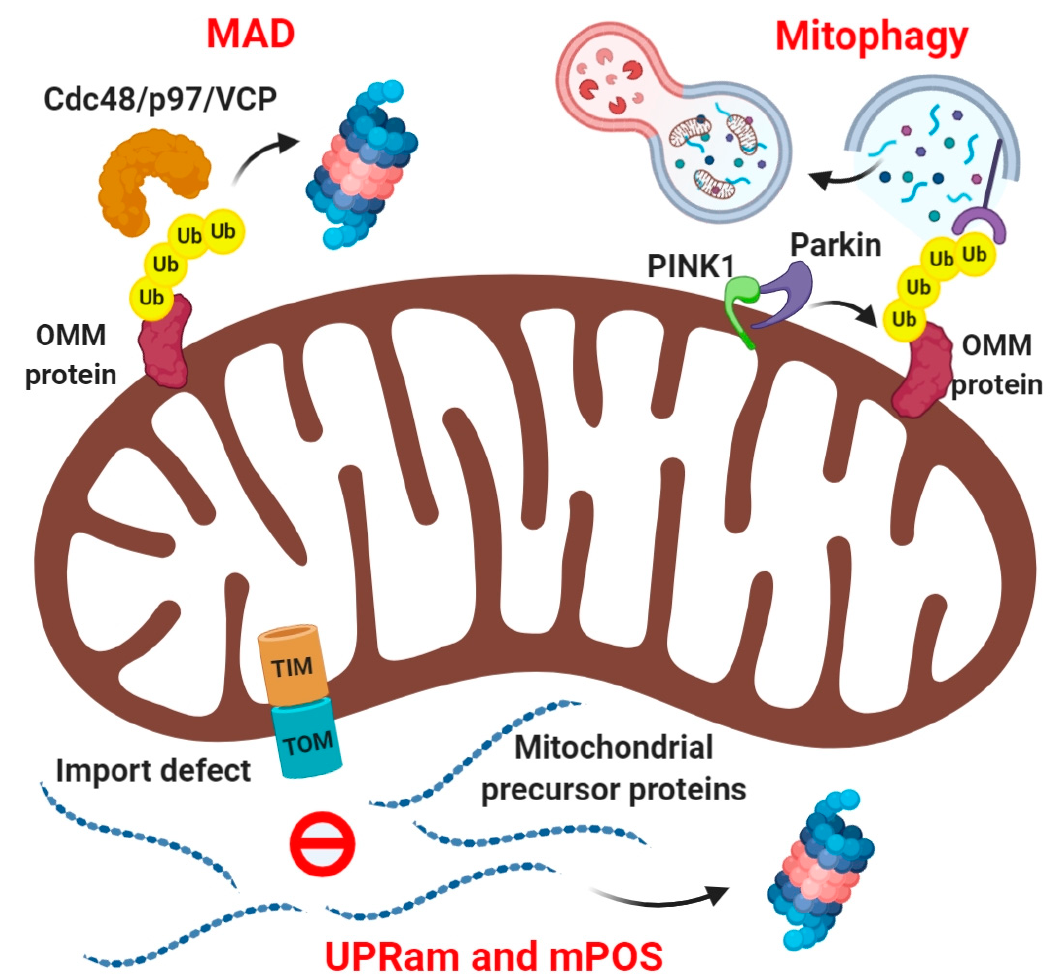
Figure 1. Regulation of mitochondrial protein quality control by cytosolic ubiquitin-proteasome system (UPS). Individually damaged proteins in the outer mitochondrial membrane (OMM), are selectively ubiquitinated by specific E3 ligases, extracted by the AAA ATPase Cdc48/VCP/p97 and then degraded by the proteasome by “MAD” pathway. Irreversible damage to the mitochondria leads to PINK1 stabilization at OMM and subsequent recruitment and activation of E3 ligase Parkin, which extensively ubiquitinates the OMM proteins. These ubiquitin chains serve as signals for engulfment of damaged mitochondria by autophagosomes, through the pathway of “ubiquitin-dependent mitophagy”. Impaired mitochondrial protein import and sorting pathways leads to the accumulation of mitochondrial precursor proteins in the cytosol, which triggers their clearance by the proteasome through pathways known as UPRam and mPOS.